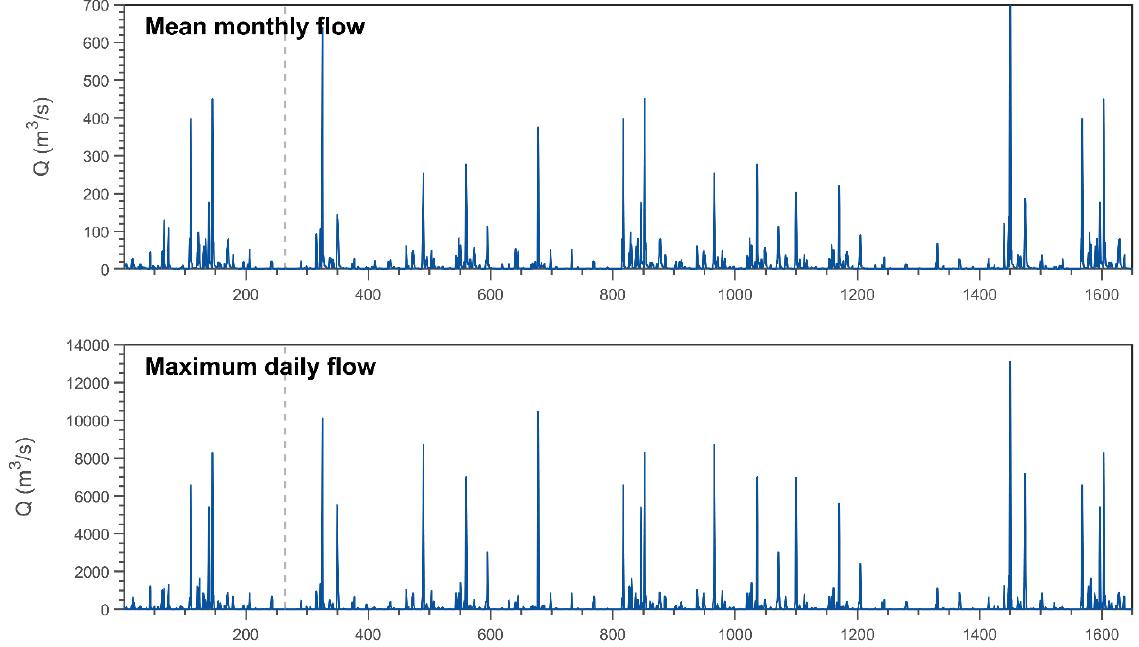
Figure A4. Mean monthly (top) and maximum daily (bottom) synthetic inflow hydrographs of additional scenario #2. The dashed line indicates the construction of the Wivenhoe